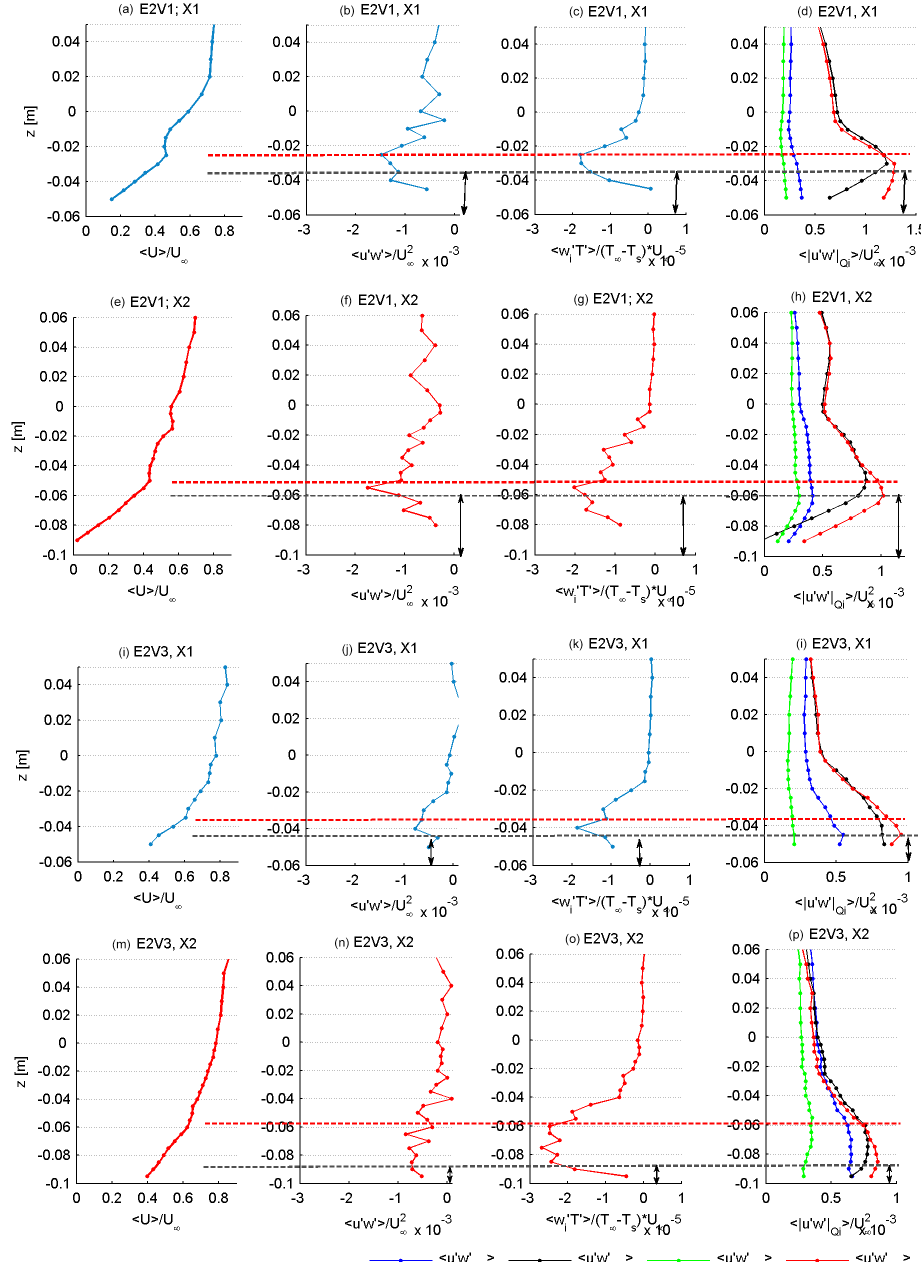
Figure 7. Near-surface vertical profiles of mean wind speed, turbulent momentum flux, turbulent heat flux, and shear stress distribution over the concave snow patch for experiment E2V1 at measurement locations X1 (a–d) and X2 (e–h) , and for experiment E2V3 at X1 (i–l) and at X2 (m–p) . Red horizontal lines mark the area of local wind maxima. Horizontal black lines indicate the upper limit of the near-surface suppression of turbulence. The black double arrow marks the layer where near-surface turbulence appears to occur.